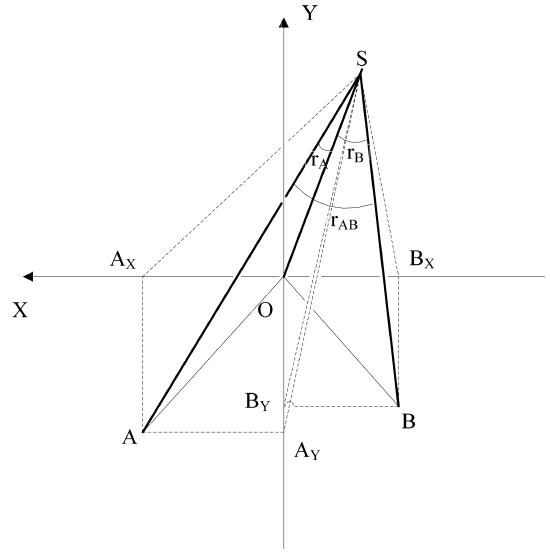
Figure 2. Coordinate system established for computing angle dis-